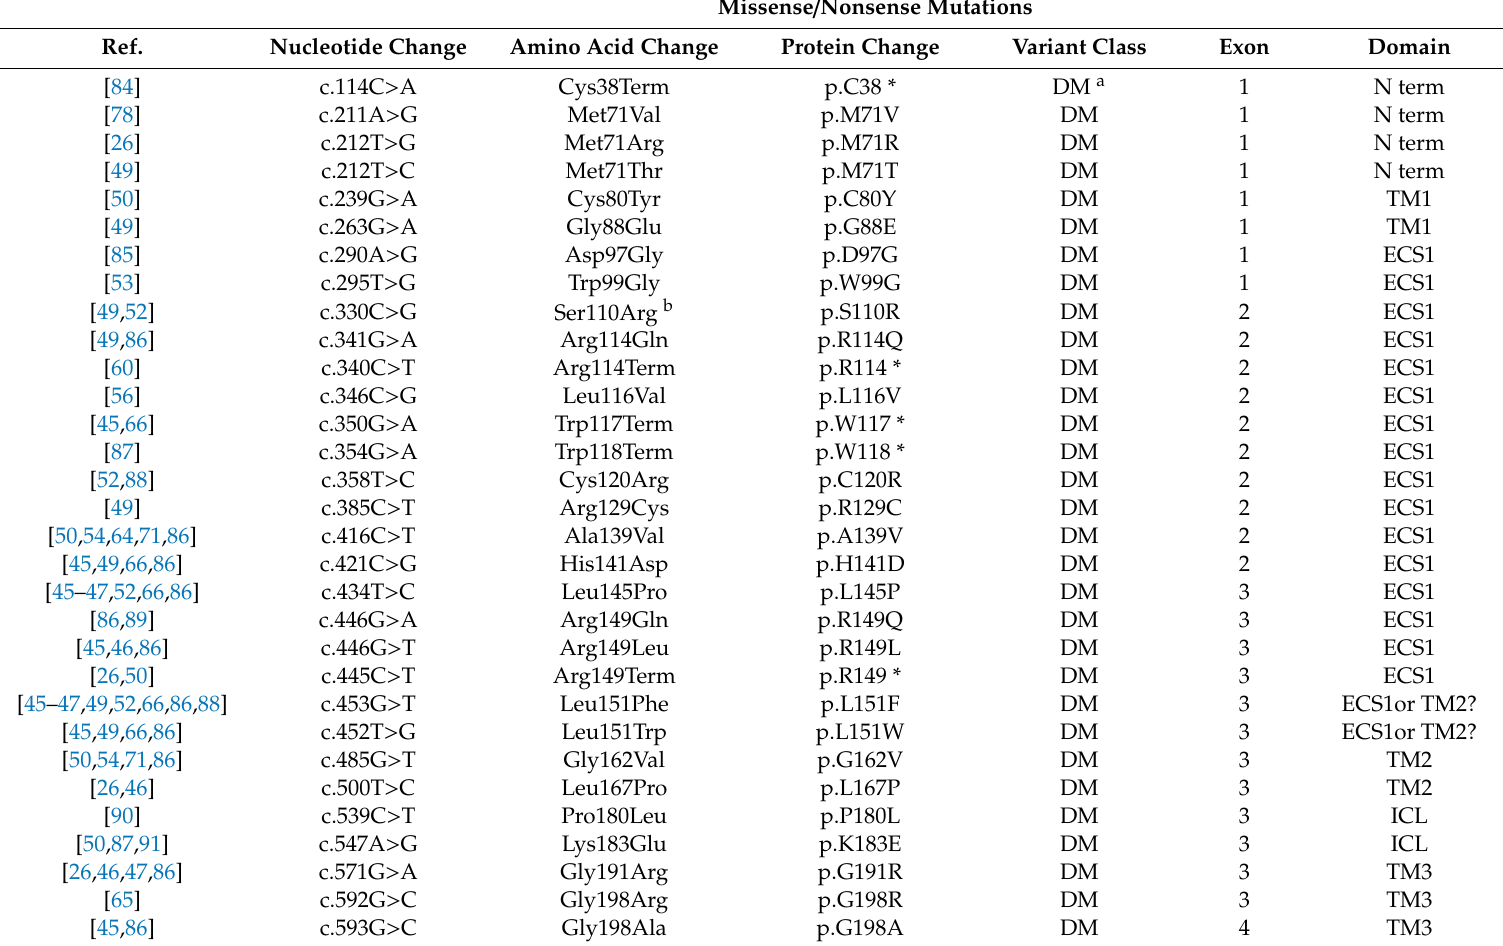
Table 4. CLDN16 disease-causing variants